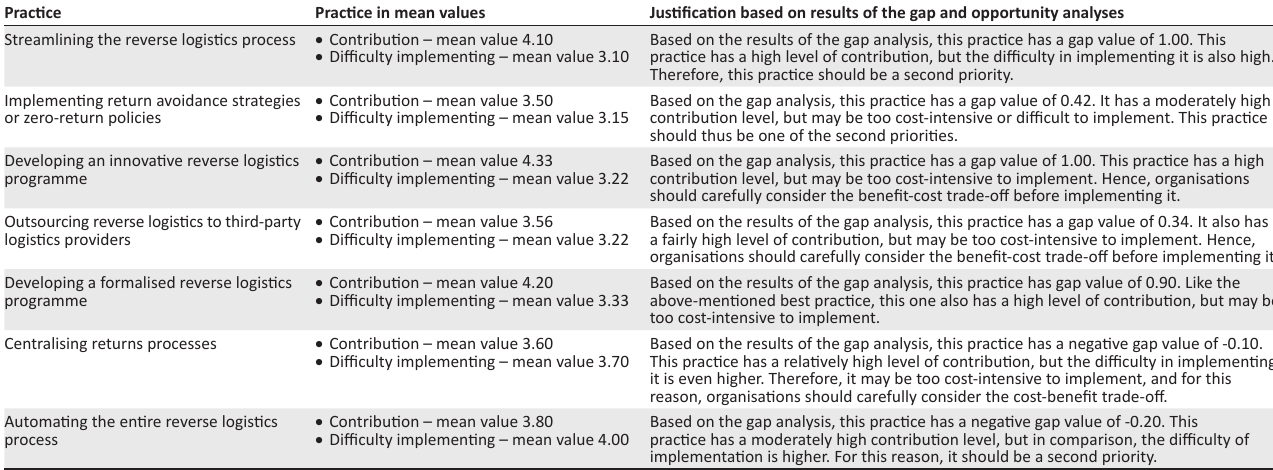
TABLE 3: Reverse logistics practices in the Oyster quadrant: Second